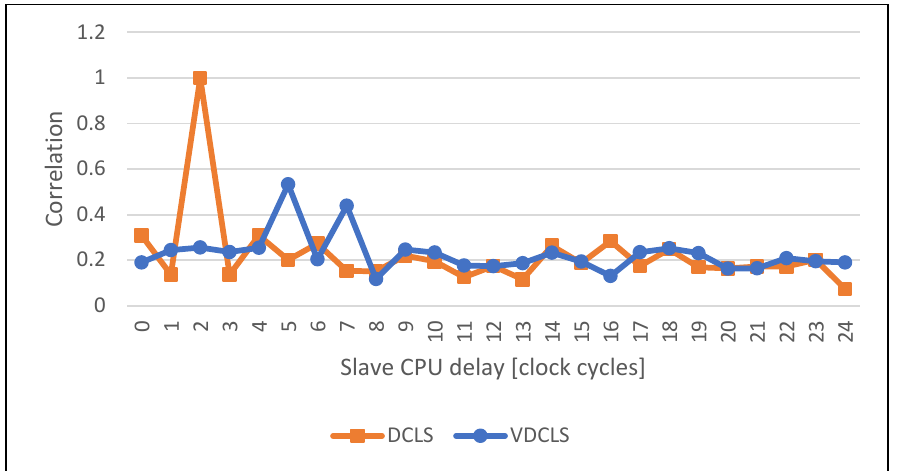
Figure 13. Comparison of the execution correlation between master and slave CPUs using VDCLS and legacy DCLS technique while executing the EDCSA verification algorithm.